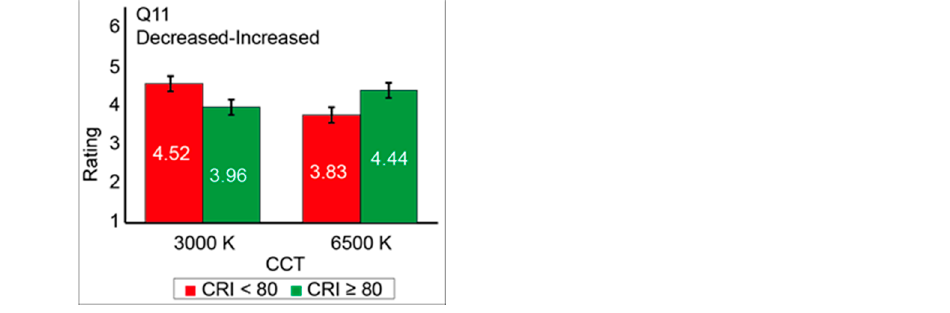
Figure 15. Interaction effect between the CRI and CCT for self-reported productivity (Q11) in experiment 2.